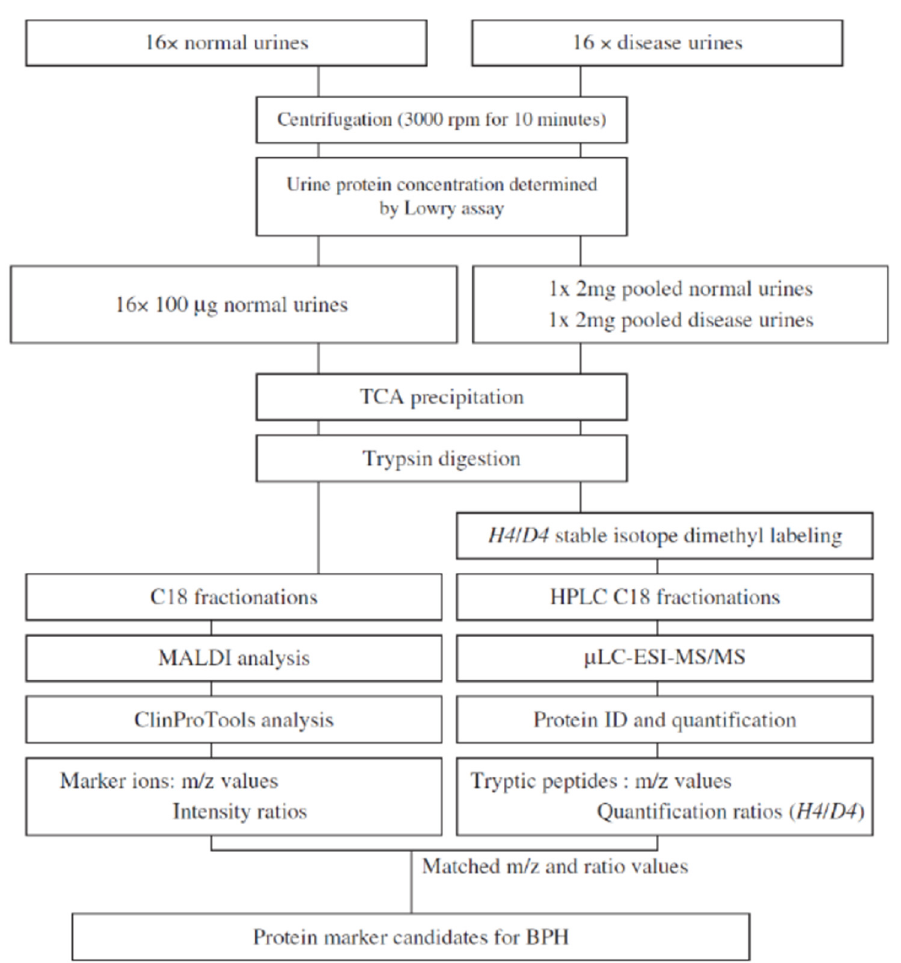
Figure 1. Schematics of the experimental workflow used in [34]. Reprinted with permission from Ref. [34]. Copyright 2011 John Wiley and Sons. Ref. [34]. Copyright 2011 John Wiley and